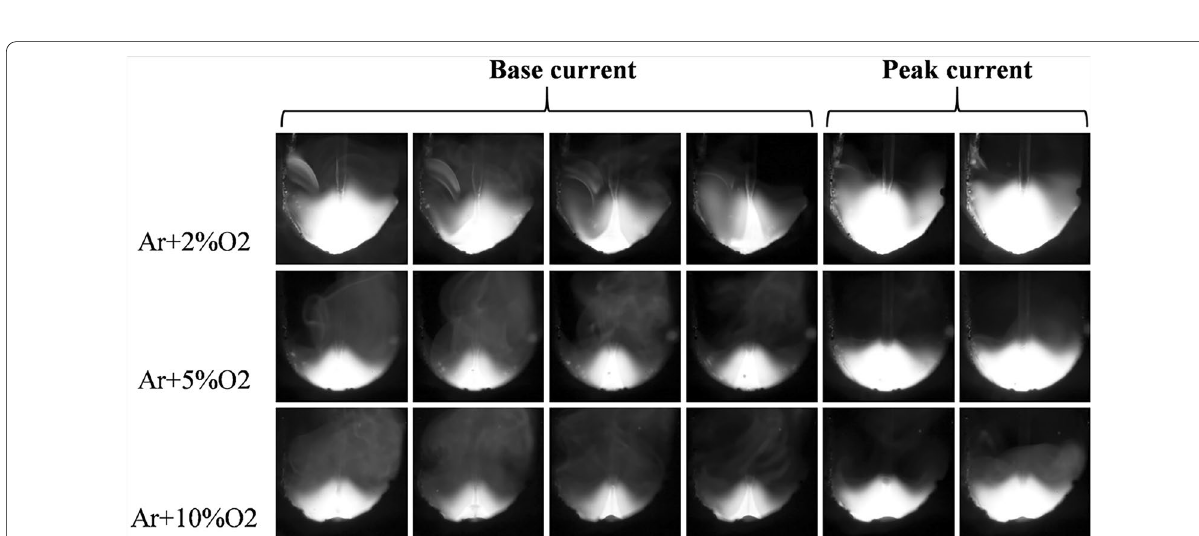
Figure 3 Variations of arc profile under shielding of gas mixtures with varied O 2